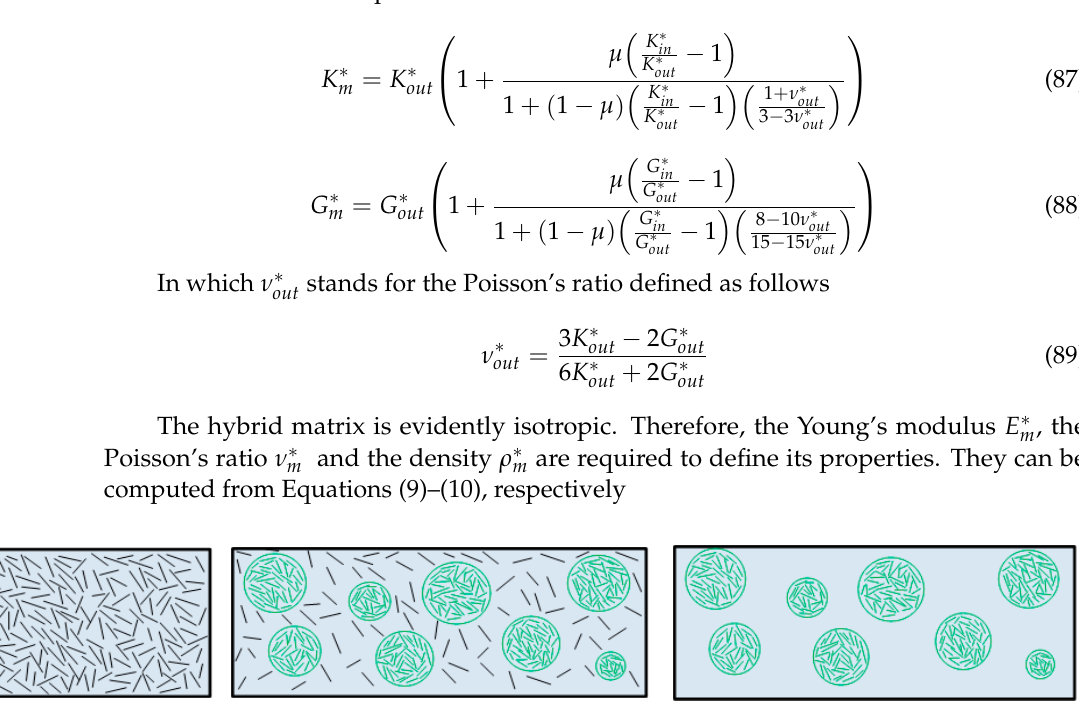
Table 6. Mechanical properties used in the Matlab code and Digimat MF for CNT and GNP. CNT